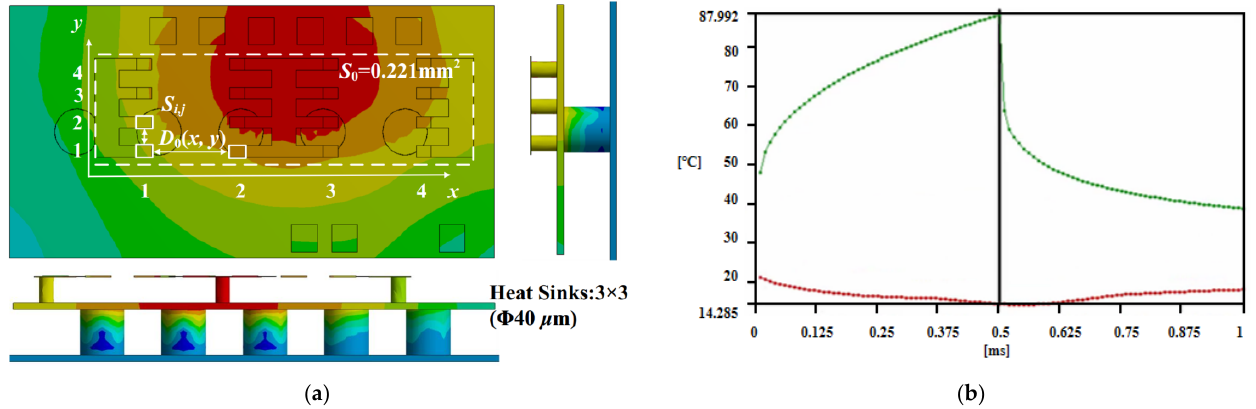
Figure 10. ( a )Thermal modeling of proposed bias PA; ( b )Temperature distribution of thermal sim- ulation.